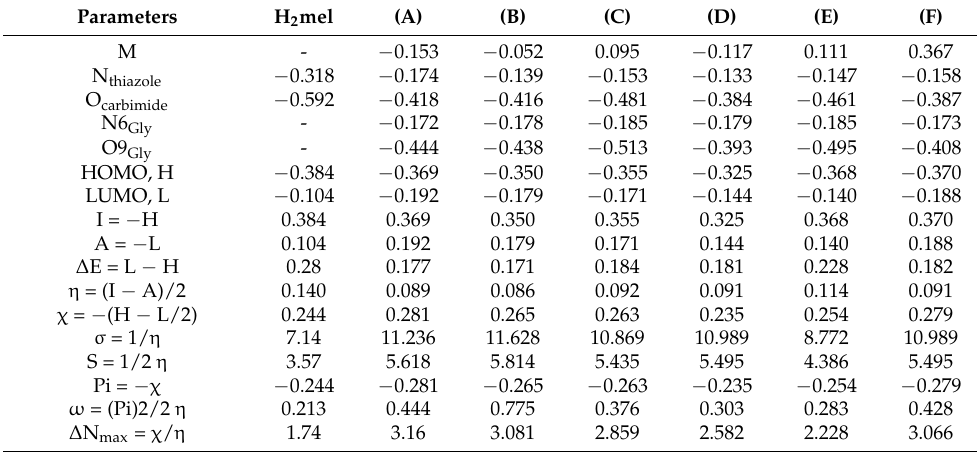
Table 4. Calculated charges on donating sites and energy values (HOMO, LUMO, energy gap ∆ E/eV, hardness ( η ), global softness (S), electro negativity ( χ ), absolute softness ( σ ), chemical potential (Pi), global electrophilicity ( ω ) and additional electronic charge ( ∆ N max ) of the H 2 mel and studied complexes by using DFT